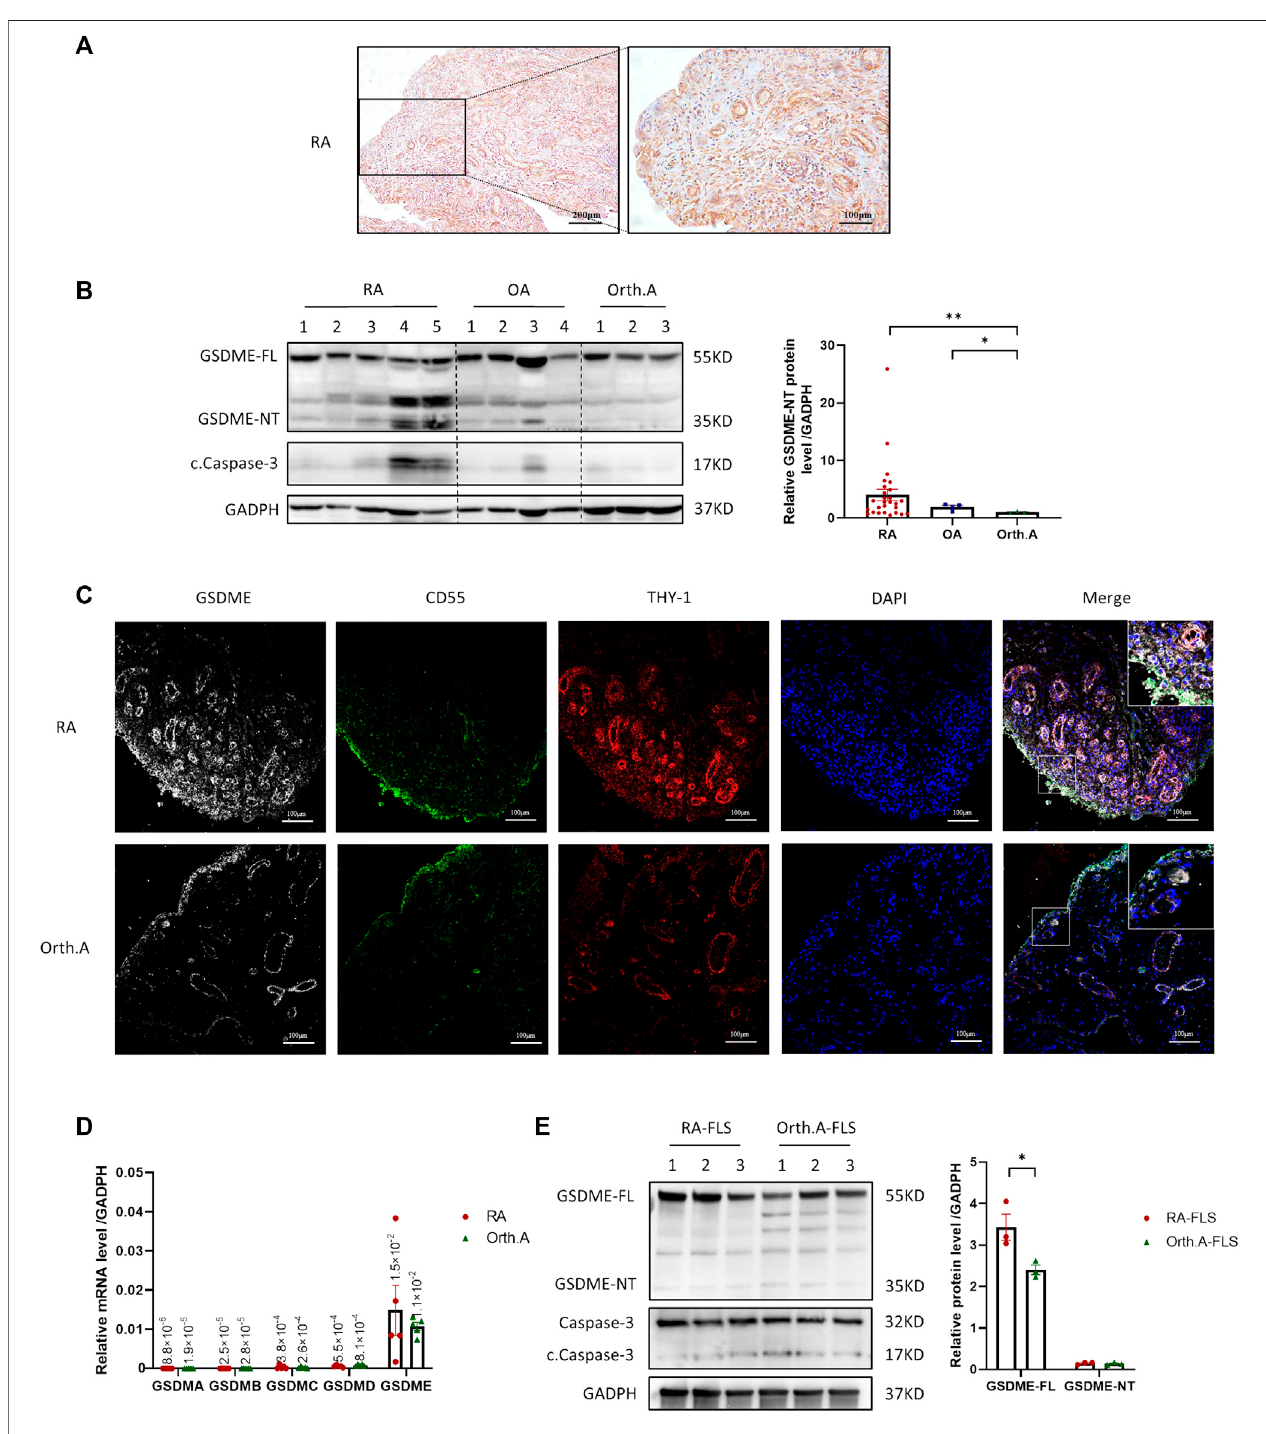
FIGURE 1 | Expression of GSDME in synovium tissue and RA-FLSs. (A) Representative IHC staining of GSDME in synovium from RA patients (scale bar = 200 / 100 μ m). (B) Westernblotofcleavedcaspase-3,GSDMEandN-terminalcleavageexpressioninlysateofsynoviumtissuesfromRA( n =27),OA( n =4)andOrth.A( n =3) patients. (C) Representative immuno fl uorescence staining of GSDME (Gery), CD55 (Green), THY-1 (Red) and DAPI (Blue) in synovium of RA and Orth. A patients (scale bar = 100 μ m). (D) GSDMA-E mRNA expression in FLSs from RA ( n = 5) and Orth. A ( n = 5) patients evaluated by qPCR. (E) GSDME-FL, GSDME-NT, caspase-3 and cleaved caspase-3 protein expression in FLSs from RA patients ( n = 3) and Orth.A patients ( n = 3) evaluated by western blot. Data are shown as mean ± s.e.m. * p < 0.05, ** p < 0.01 using one-way ANOVA.